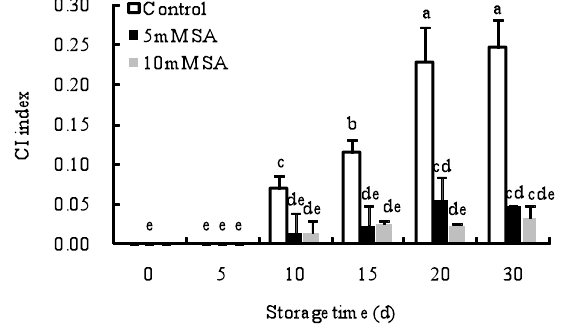
Fig. 1: Changes of CI index in ‘Huangguan’ pear by SA treatment during cold storage. Values are mean ± standard error (SE) of three repli- cates. Different letters represent significant differences at P = Tab. 2: Effect of SA on fruit quality in ‘Huangguan’ pear